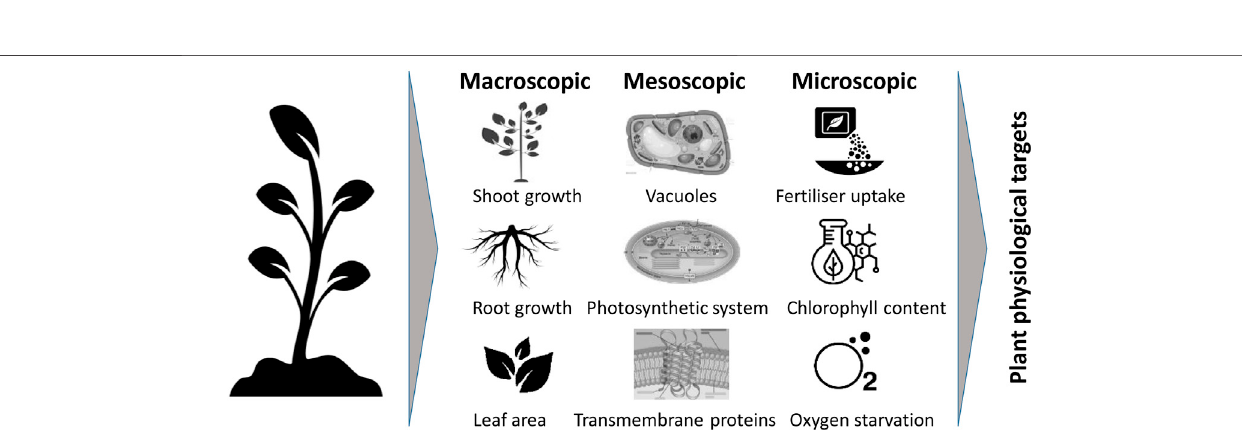
Frontiers in Astronomy and Space Sciences |